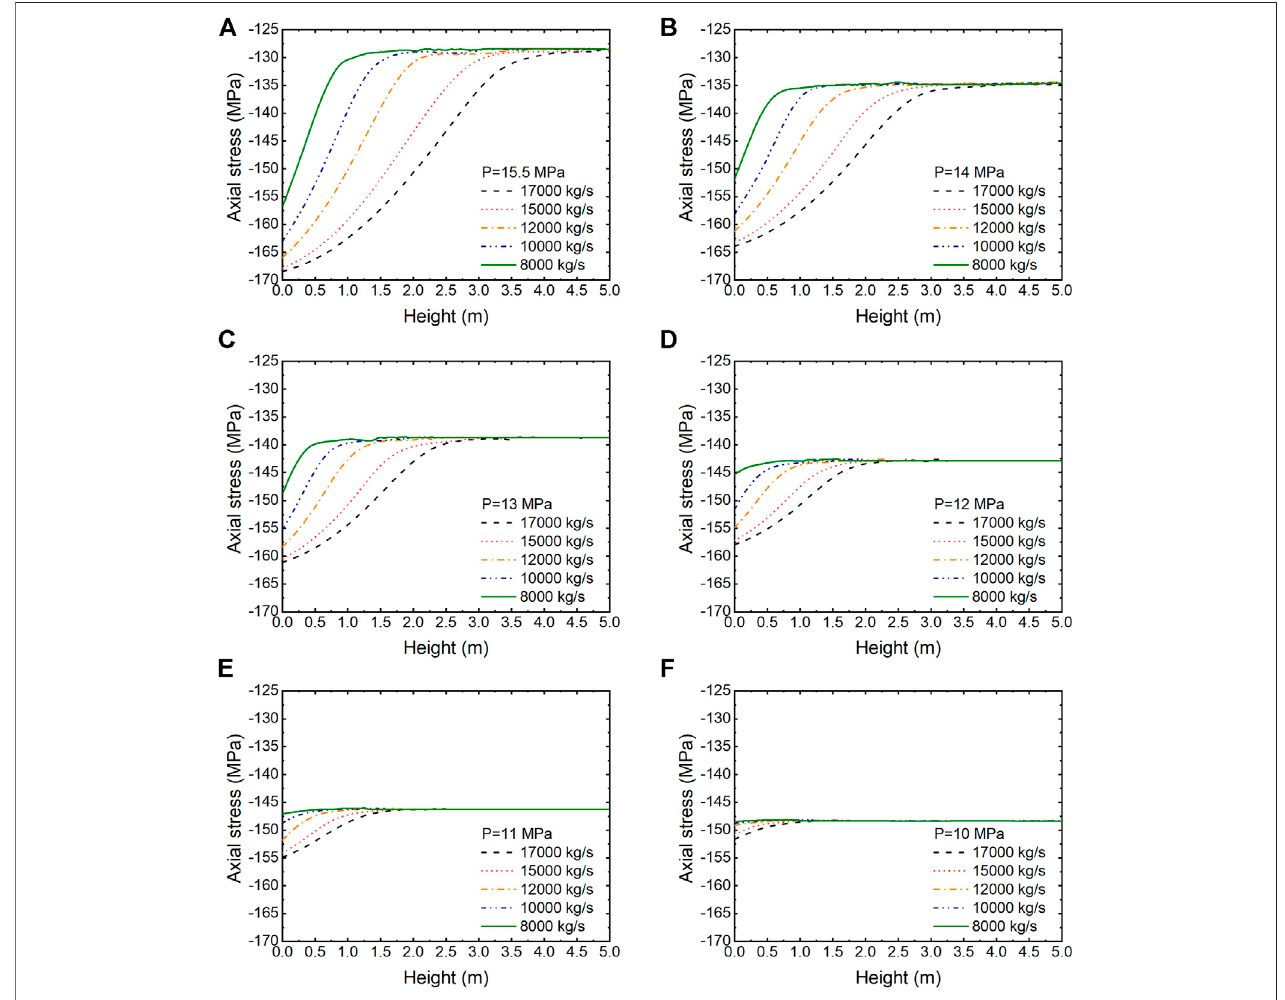
FIGURE 15 | Axial stress of UO 2 fuel at 117 WM h/kg(U) under different coolant pressures and mass fl uxes.